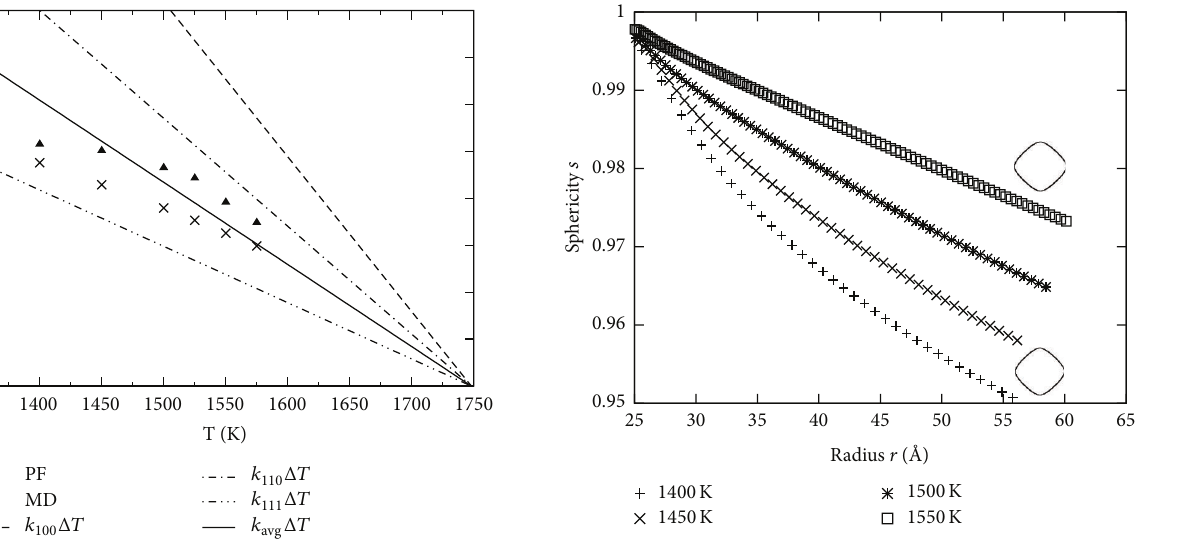
Figure 6: Asymptotic radial velocity versus temperature. Values of V ∞ are obtained from the asymptotic limit of the fits shown in Figure 5.